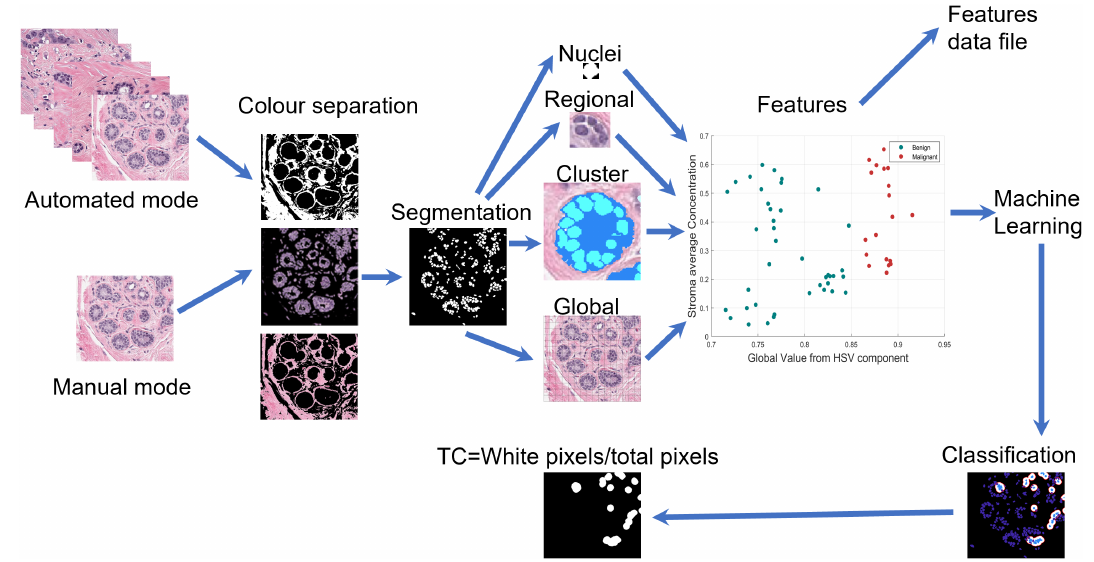
Figure 3. Graphical illustration of the pipeline of the methodology. Under two operational modes images are processed to extract features at nuclei, regional, cluster, and global image regions either to classify and assign Cellularity or to extract same features in order to an archive